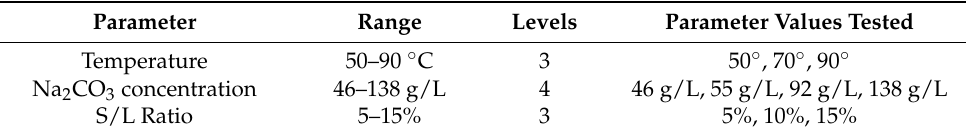
Table 1. Parameters tested in the laboratory scale tests, their range, levels and corresponding values